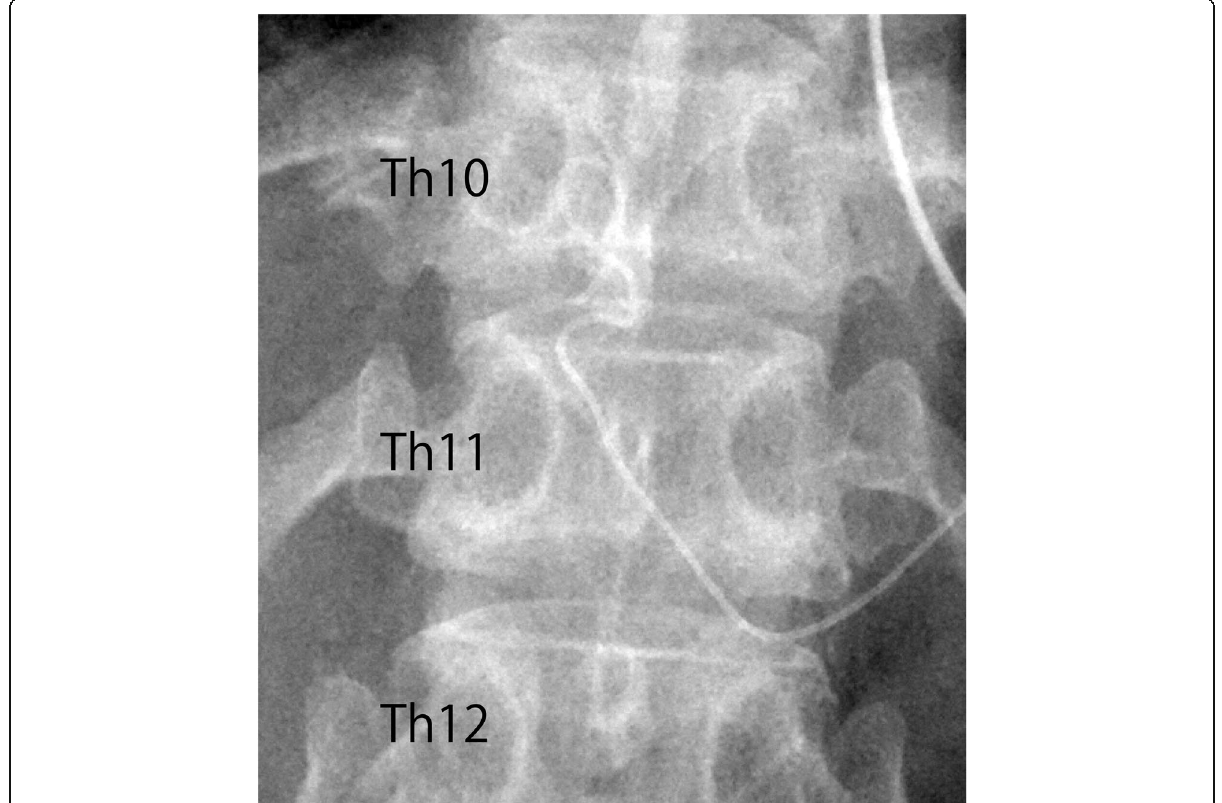
Fig. 2 A plain abdominal X-ray taken after the